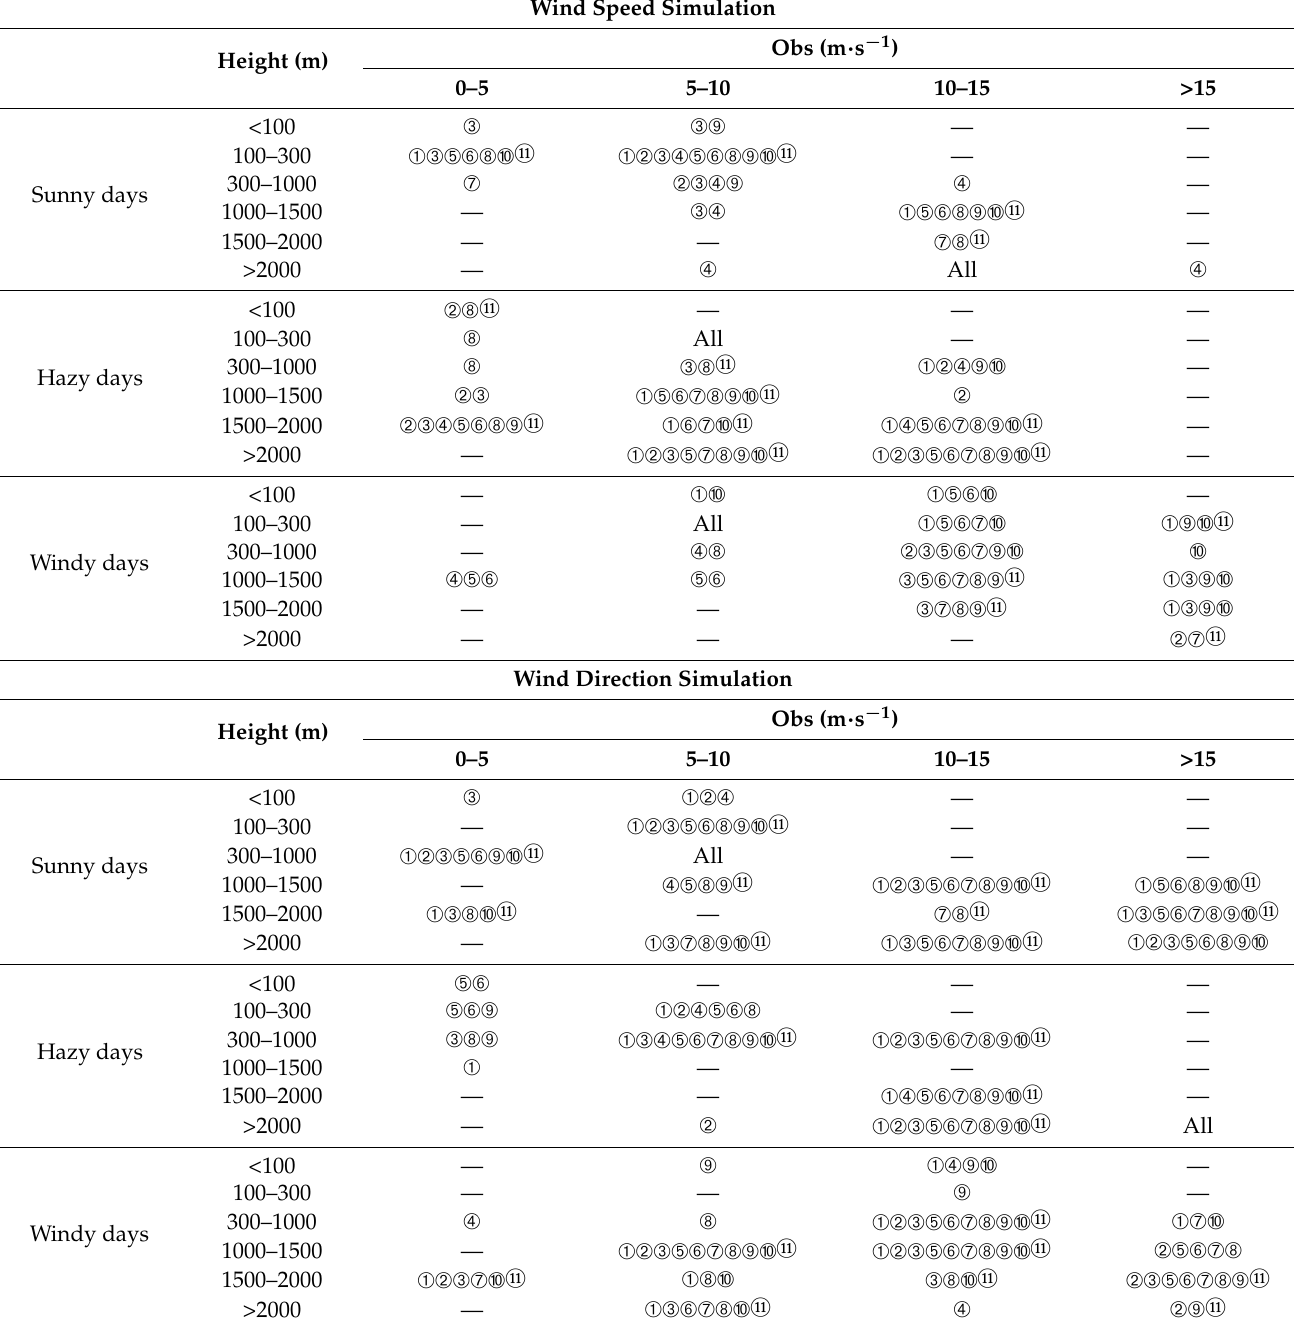
Figure 4. The wind field simulations ( a – f ) with the PBL schemes of YSU, MYJ, QNSE, BouLac, UW and Shin-Hong Schemes and their biases ( g – n ) against the observations. The sunny, haze and windy days were on 24–25 February, 26–27 February and 28 February to 1 March, respectively. Table 3. Under different conditions, the PBL schemes with low biases of wind speed and direction, large correlation coefficients, and close standard deviation on sunny days, hazy days and windy days, and at four wind speeds ranges (0–5, 5–10, 10–15, over 15). The bias of suitable scheme in the table is below 20%. “—” Indicates poor simulation or no data. “All” means all the PBL schemes.